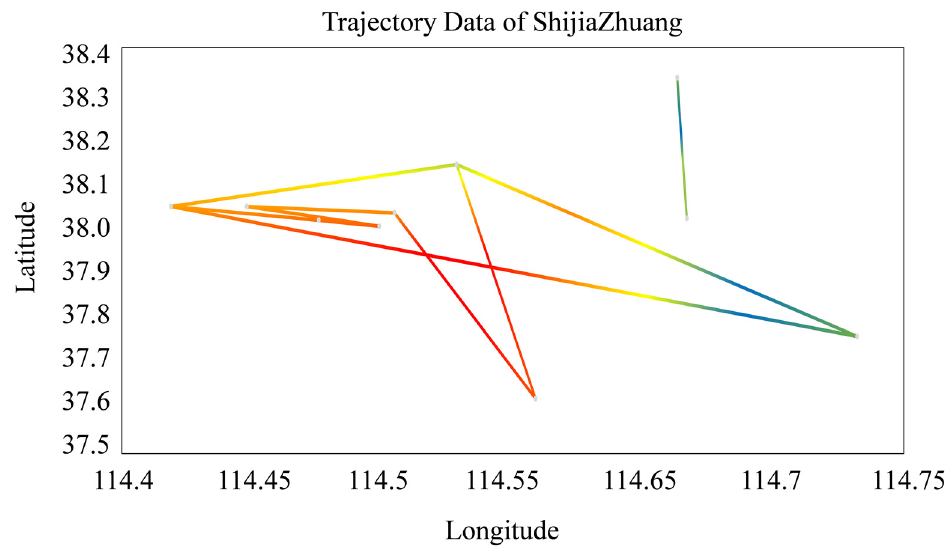
Figure 7. Heat map of trajectory data of Tianjin city.